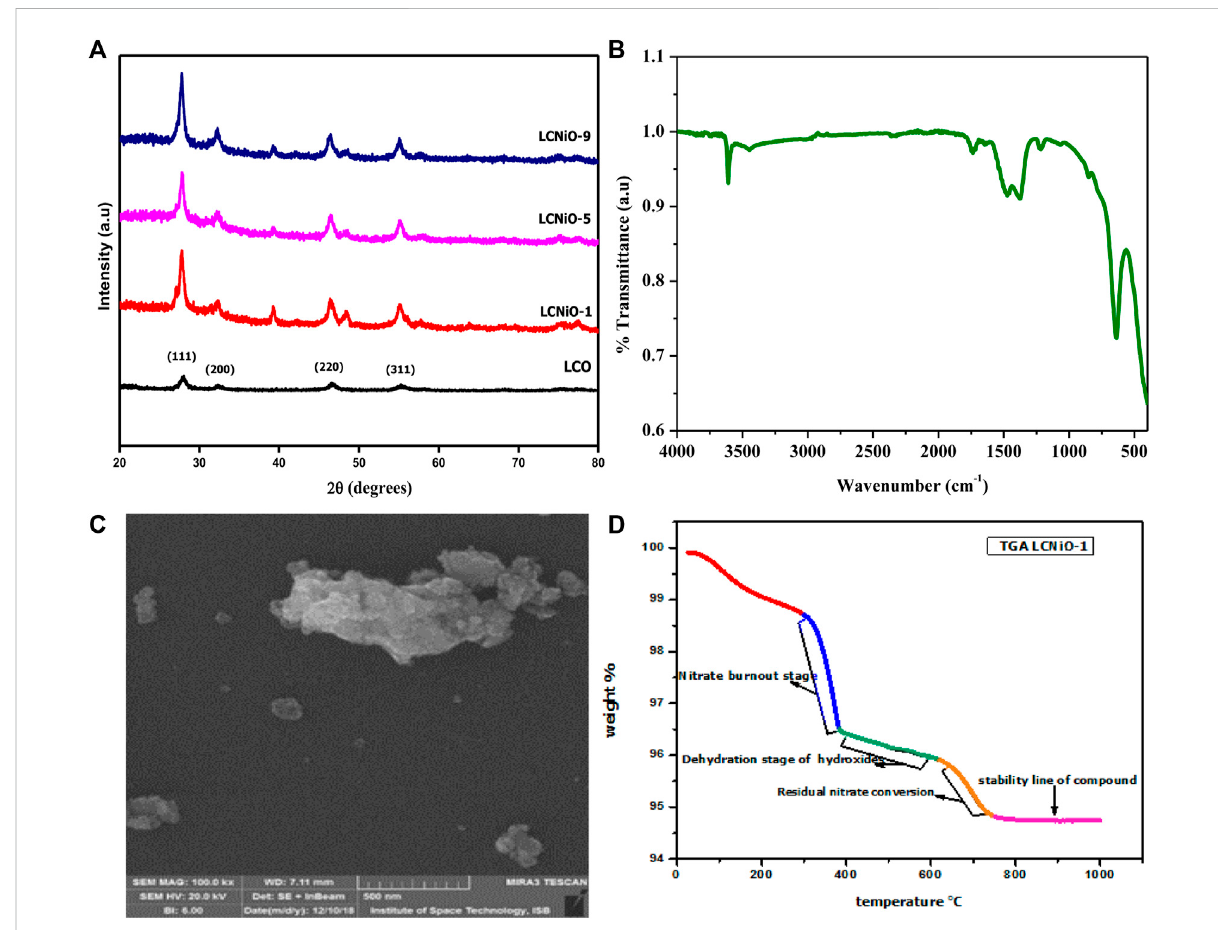
FIGURE 2 (A) An overlay of XRD patterns of pure and nickel-doped lanthanum cerates; LCNiO-1 to LCNiO-9, (B) FTIR spectrum for LCNiO-9, (C) SEM micrograph of LCNiO-9, and (D) TGA plot for